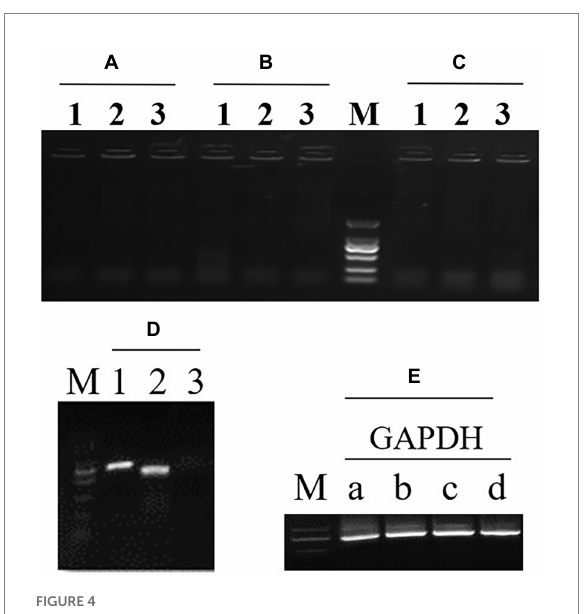
FIGURE 4 RT-PCR detection of the first (1) and second (2) exon in ATG9 gene and the first exon with intron (3) to detect the gDNA. (A–C) Three ATG 9 RNAi strains. (D) The wild type strain NP11. (E) There is an endogenous gene GAPDH as a